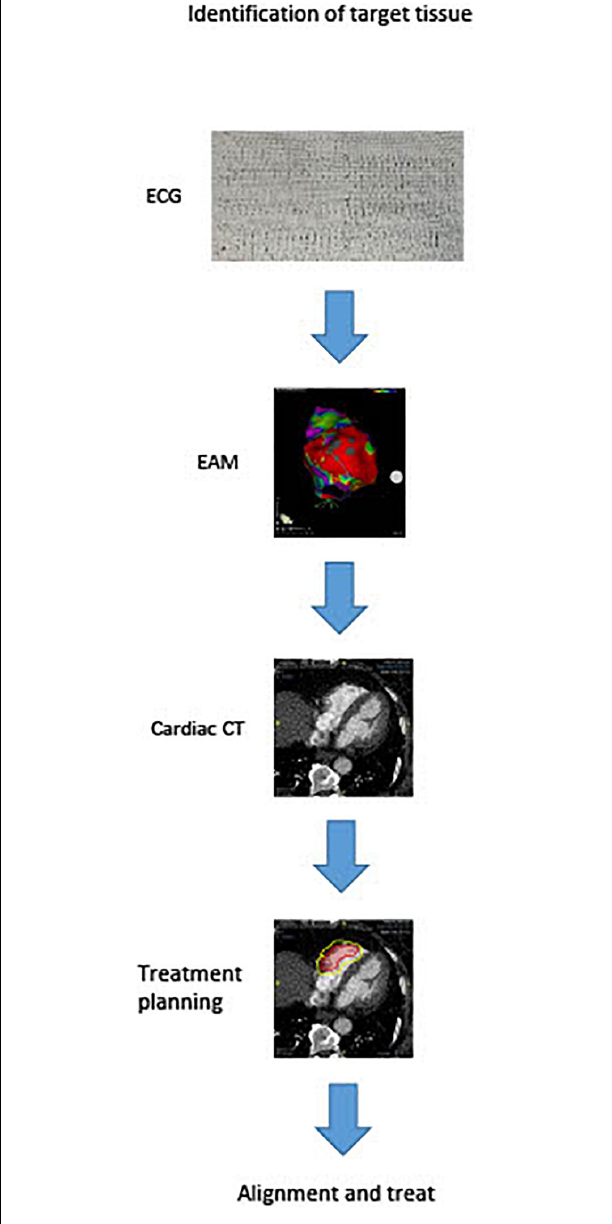
FIGURE 2 | STAR technique